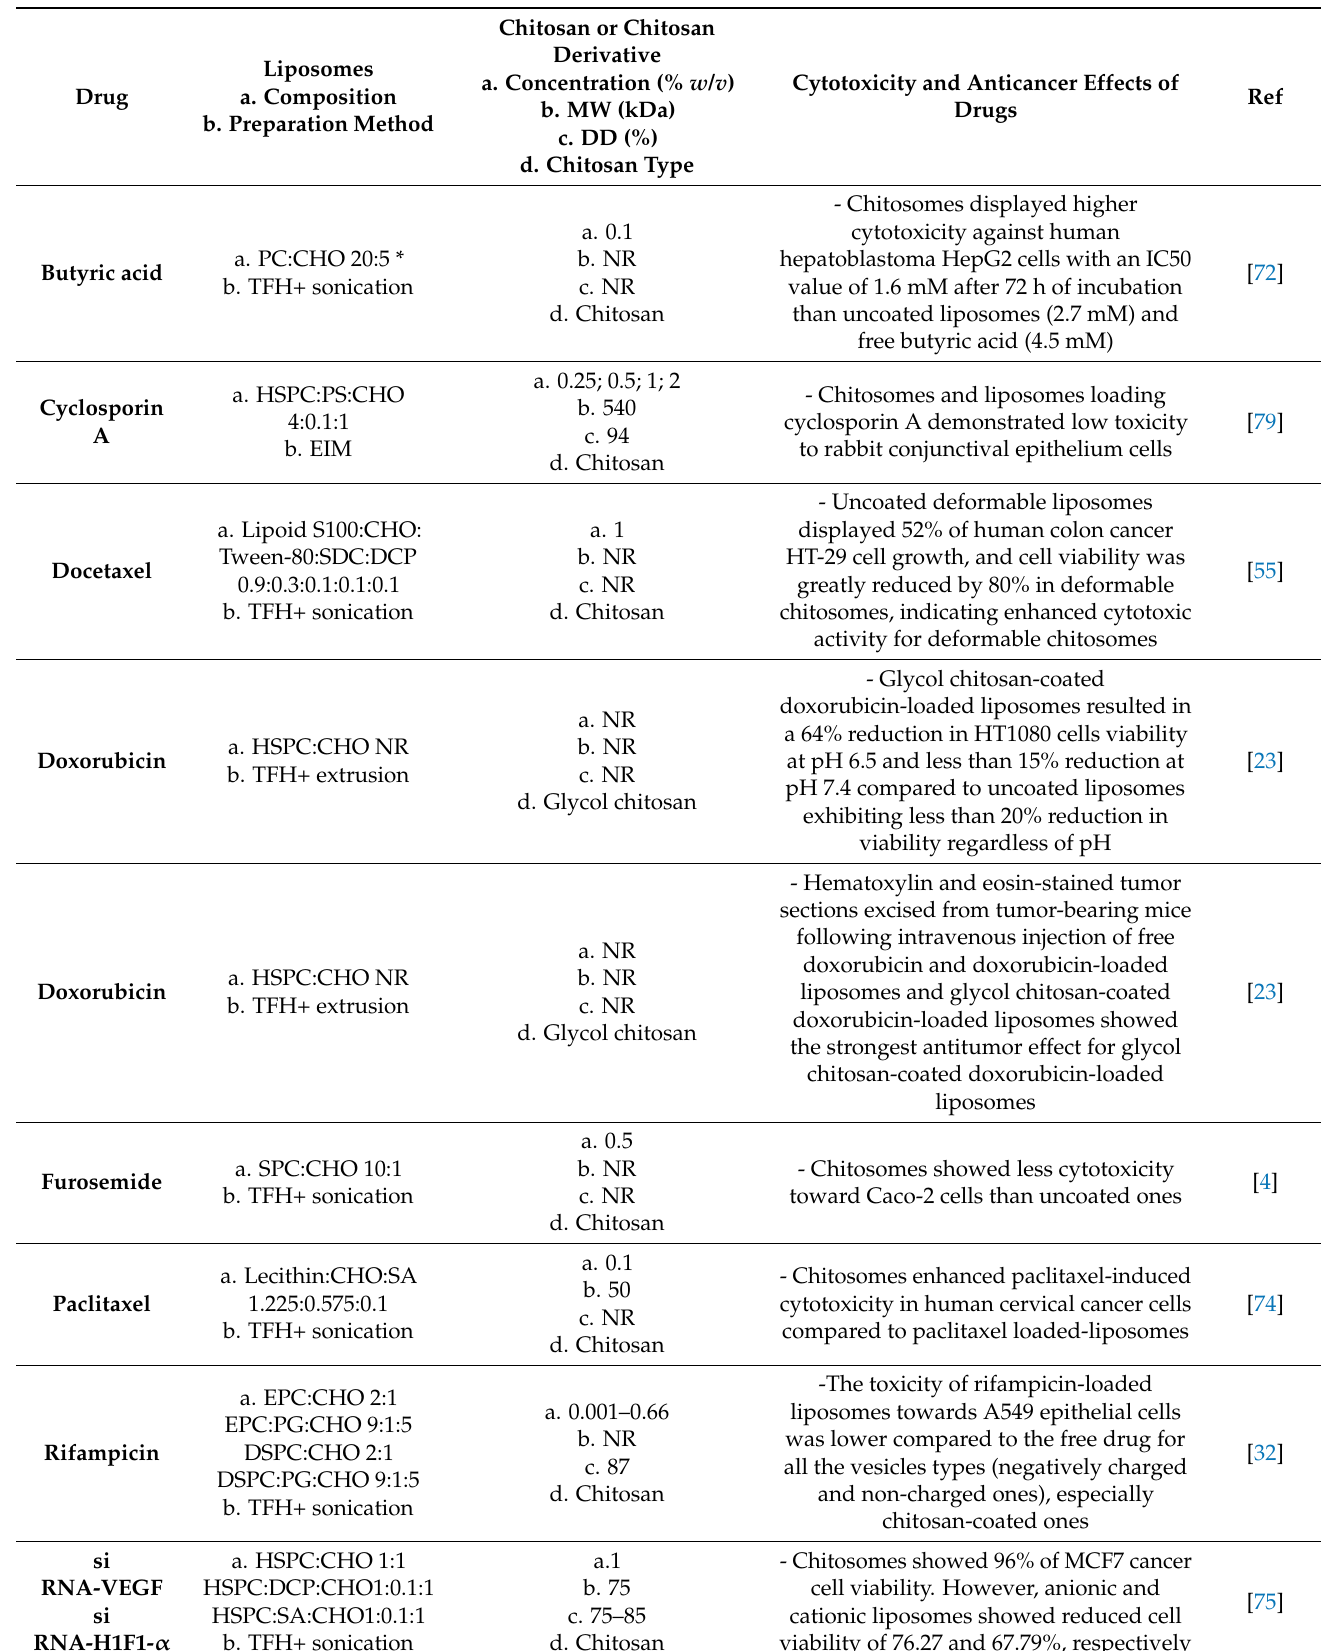
Table 11. Cytotoxicity and anticancer effect of drugs: conventional liposomes and chitosomes. The liposomal composition is indicated in the table in molar ratio except when * exists, indicating a weight ratio ( w/w